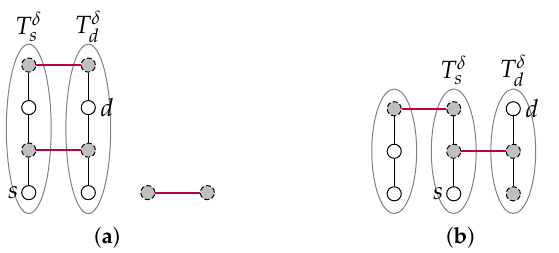
( d ) ⊆ F . ( a ) k = 4 required; ( b ) k = 3 ( s ) ∪ N T δ d s